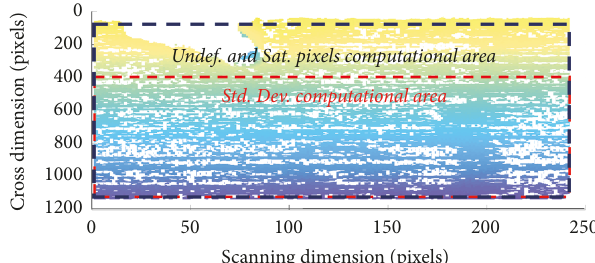
Figure 8: Regions of interest (ROI) in range images of R3. Regions R1 and R2 are marked likewise.